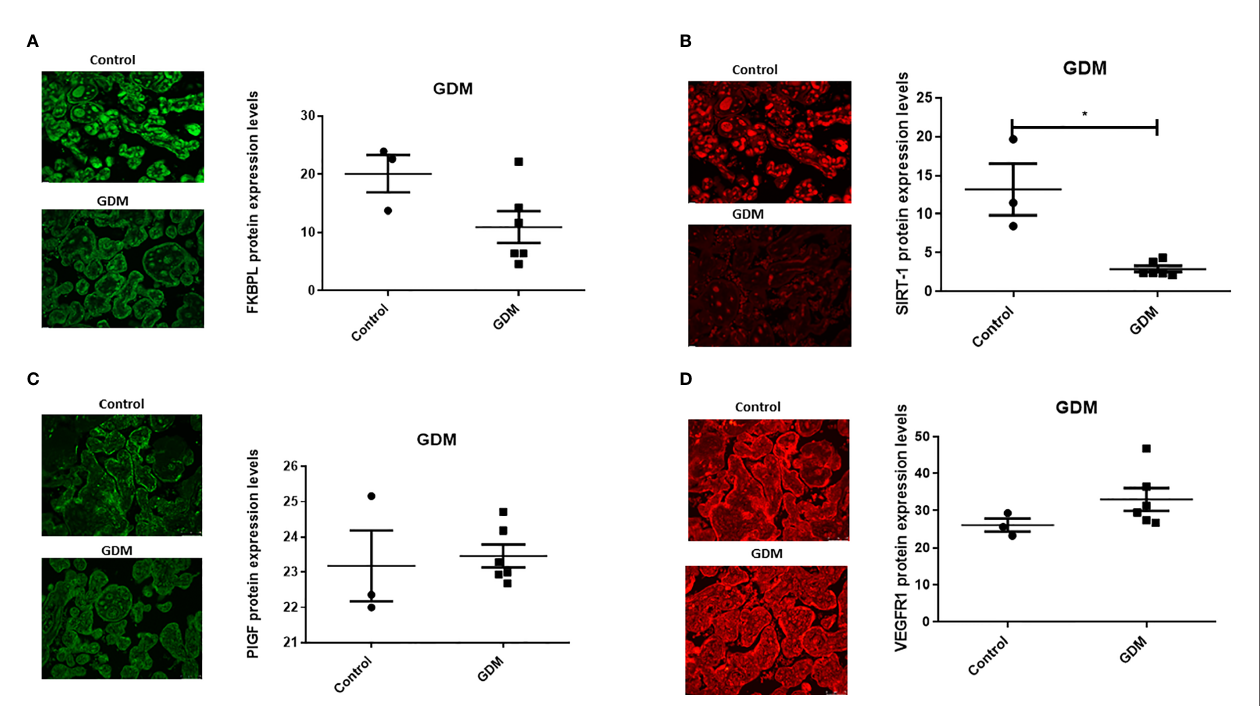
FIGURE 3 | Placental angiogenic balance is disrupted in GDM. Placental slides from women with GDM versus age, BMI and foetal sex matched controls were stained with (A) FKBPL, (B) SIRT-1, (C) PlGF and (D) VEGF-R1 primary antibodies, followed by staining with green Alexa fl our or red Cy3 secondary antibody. Six images per slide were taken at 20x magni fi cation and the mean fl uorescence quanti fi ed using Image J. Representative images inset. SIRT-1: Mann-Whitney test; n=6,